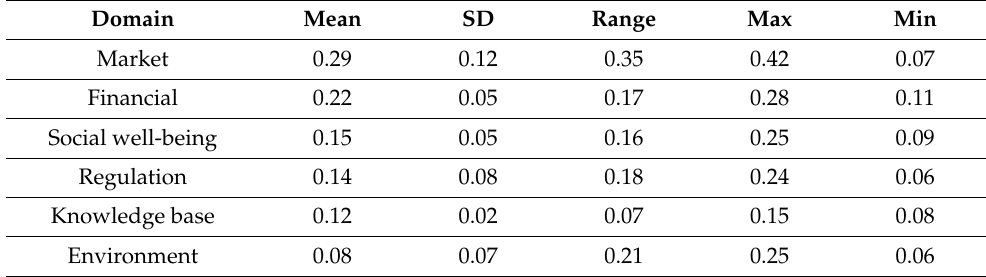
Table 4. Summary statistics for the main domains across farming business ownership